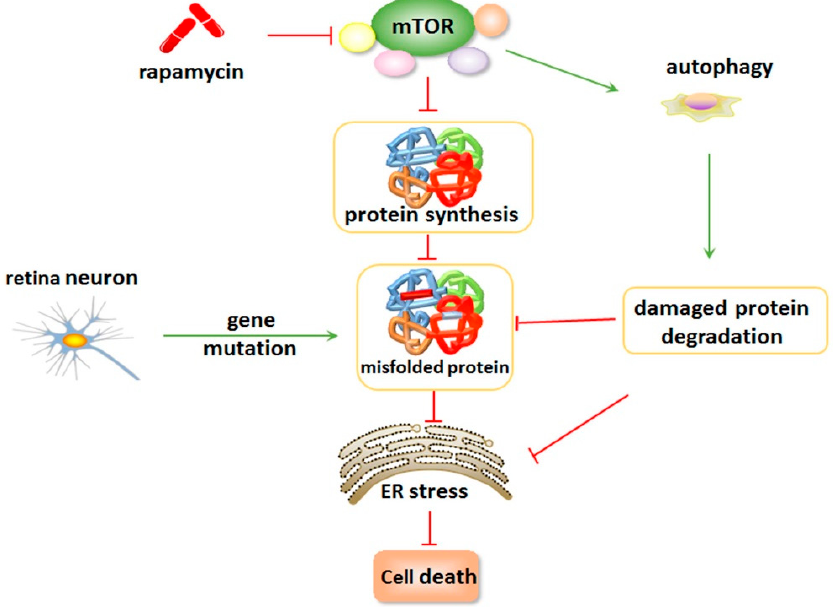
Figure 3. Inhibition of the mTOR signal suppresses ER stress-induced cell death. Inhibition of mTOR maintains cellular proteostasis and attenuates ER stress by reducing misfolded protein synthesis. In addition, inhibition of mTOR can augment autophagy to remove misfolded proteins generated from mutant genes. mTOR inhibition can suppress ER stress-induced apoptosis by regulating retina protein biosynthesis and degradation.